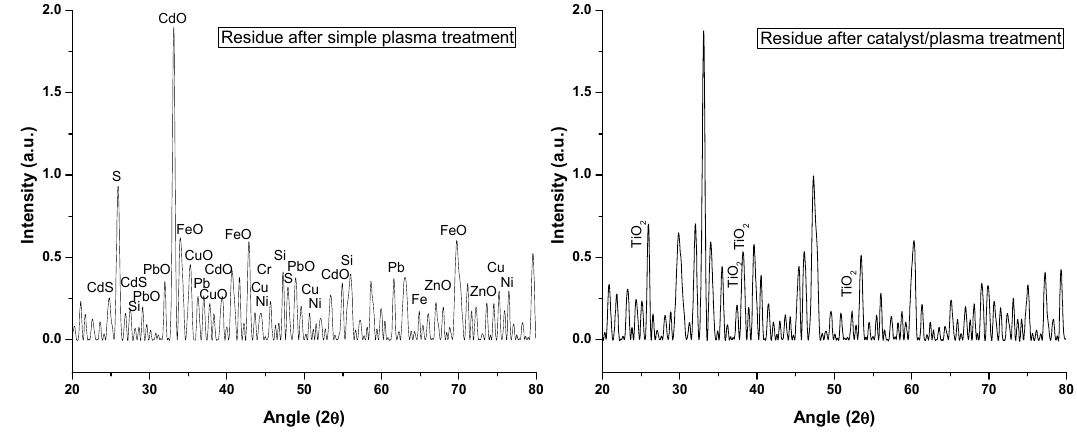
Figure 11. XRD patterns of the solid residue of plasma-treated and catalyst/plasma-treated industrial